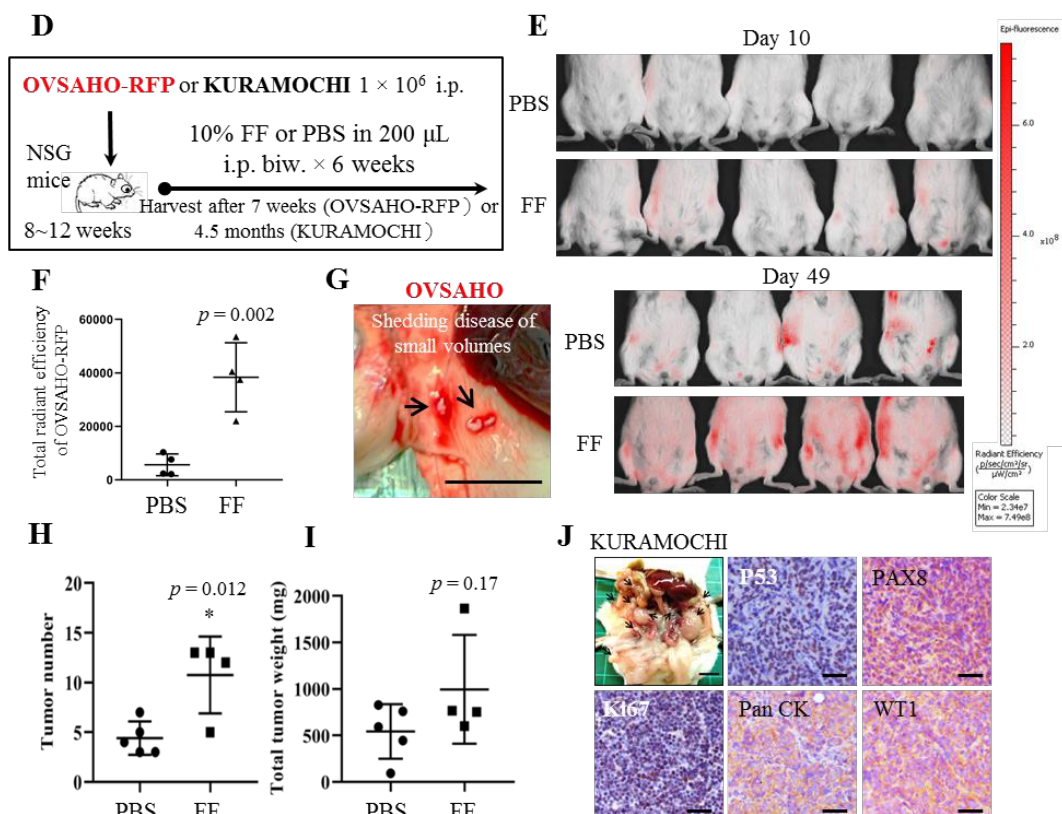
Figure 1. FF promotes intraperitoneal tumorigenesis of human immortalized fimbrial epithelial cells and HGSC cells. NSG mice were injected intraperitoneally with 1 × 10 6 FE25 ( A – C ), OVSAHO ( D – G ) or KUROMACHI ( H – J ) cells. ( A , D ) Ten percent FF or PBS was co-injected with the cells and was given as boosters weekly or twice weekly for six weeks. Mice were sacrificed by 6 months, 7 weeks or 4.5 months, respectively. ( B ) Representative intraperitoneal tumor growths (arrows) on the ovary and omentum (left), the mesentery and parietal peritoneum (middle), and the forming of mesentery- omentum cake (right) were shown. ( E ) Tumor growths from RFP-labeled OVSAHO cells (OVSAHO-RFP) were detected by using the IVIS imaging system. ( C , J ) Histology of representative tumors was shown by hematoxylin and eosin stain and immunohistochemistry with antibody against Pan-CK, P53, PAX8, WT1, Ki67, and/or MMP2/9. Scale bars represent 50 µ m. ( F ) The total radiant efficiency of OVSAHO-RFP intraperitoneal tumors was compared between the PBS- and FF-injection groups. ( G ) The OVSAHO-RFP xenograft demonstrated low-volume seedings on the peritoneum. ( H , I ) Numbers and total weight of the KURAMOCHI intraperitoneal tumors in the PBS- and FF-injection groups. The asterisk represents a comparison of the vehicle. * p < 0.05, by two-sided, unpaired Student’s t